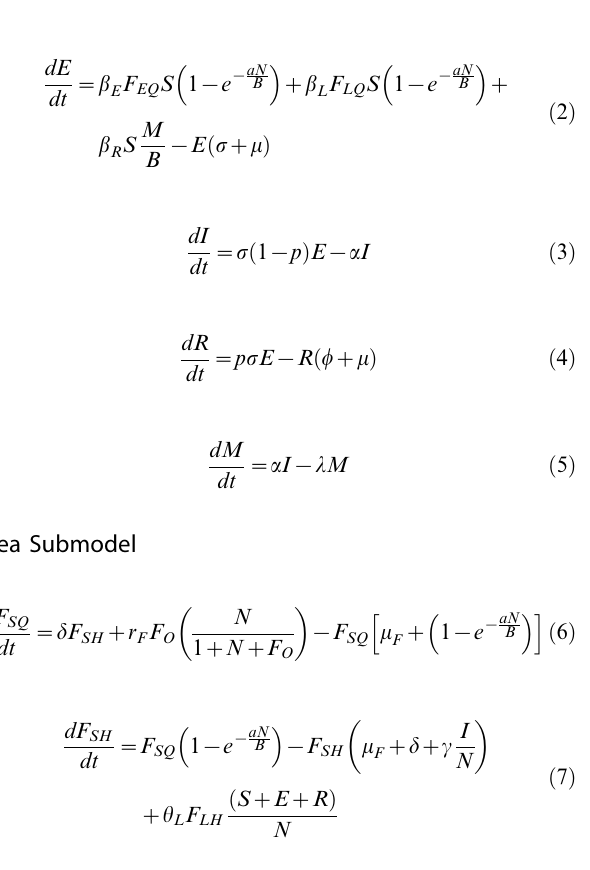
Table 1. Host and flea variables.